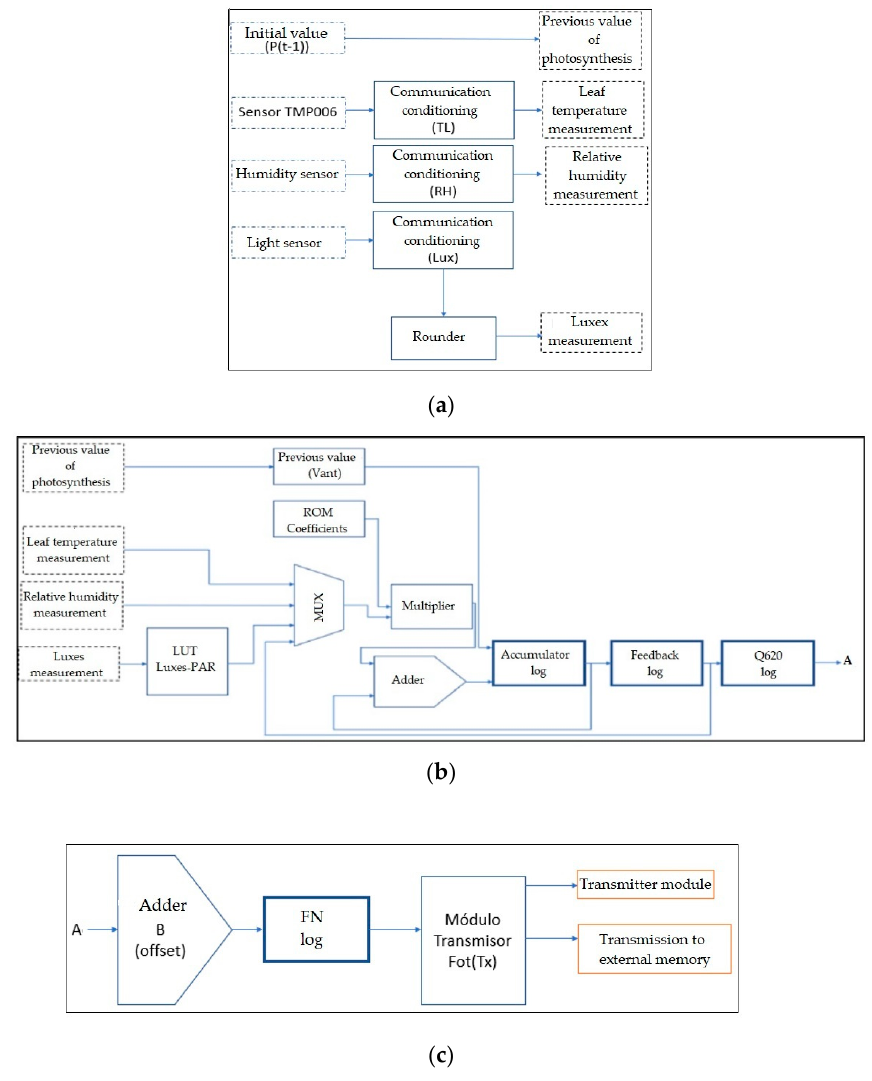
Figure 13. Complete structure of the design of the mathematical model in the FPGA. ( a ) Variable acquisition and conditioning unit, ( b ) variable processing unit (digital implementation of the black- box mathematical model), and ( c ) offset adjustment and serial transmitter